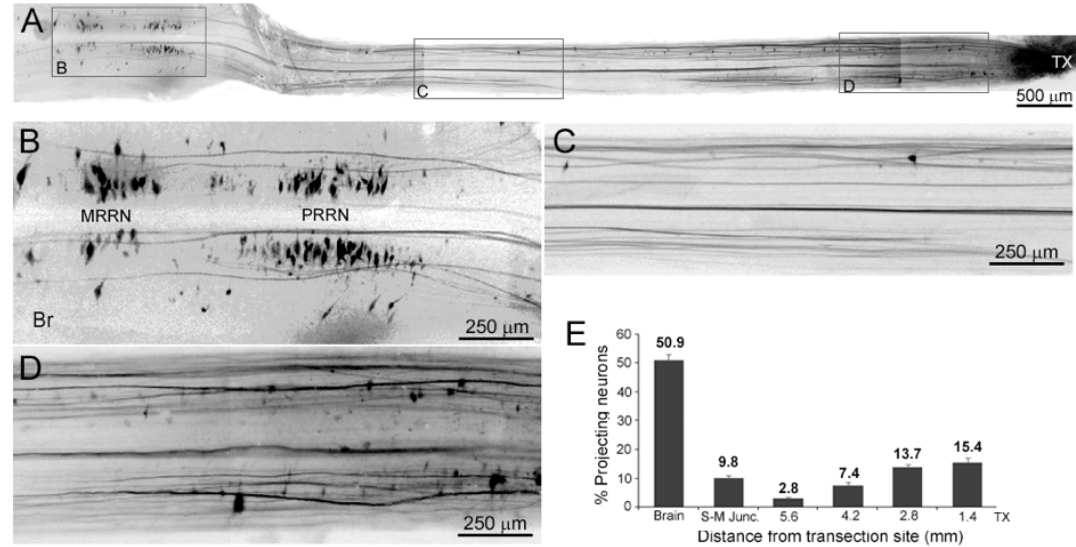
Figure 7. The sources of early regenerating axons. At 2 weeks post-TX, DTMR was applied to a re-TX at the original injury. ( A ) a composite low magnification view showing the entire brainstem and the SC as far as the TX site. The largest number of retrogradely labeled cells are small RS neurons in the brainstem, but some are local neurons near the TX site. ( B ) enlarged images from the boxes in ( A ) show that most early regenerating axons descend from small- to medium-sized RS neurons in the